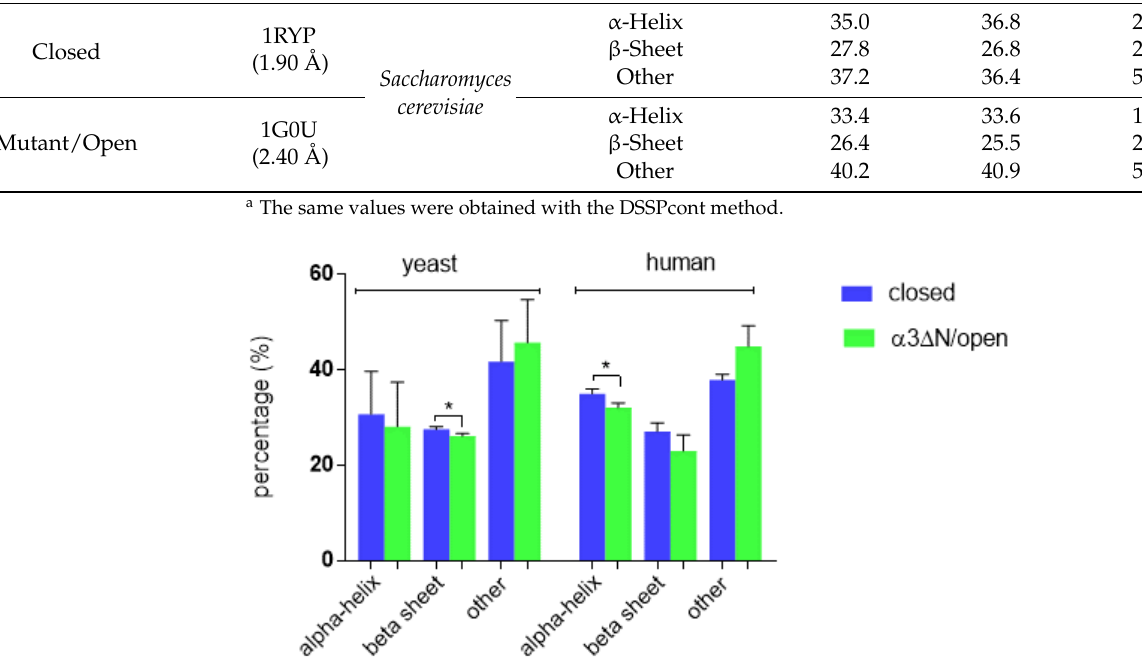
Figure 1. Comparison of secondary structure content in yeast (left) and human (right) 20S pro- teasomes in putative open- and closed-gate conformations. The column graph shows the means (+/ − SEM) of percentages of alpha-helix, beta-sheet, and other structural motifs in closed (blue columns) and open proteasome (green columns) calculated using four different methods (DSSP, DSSPcont,